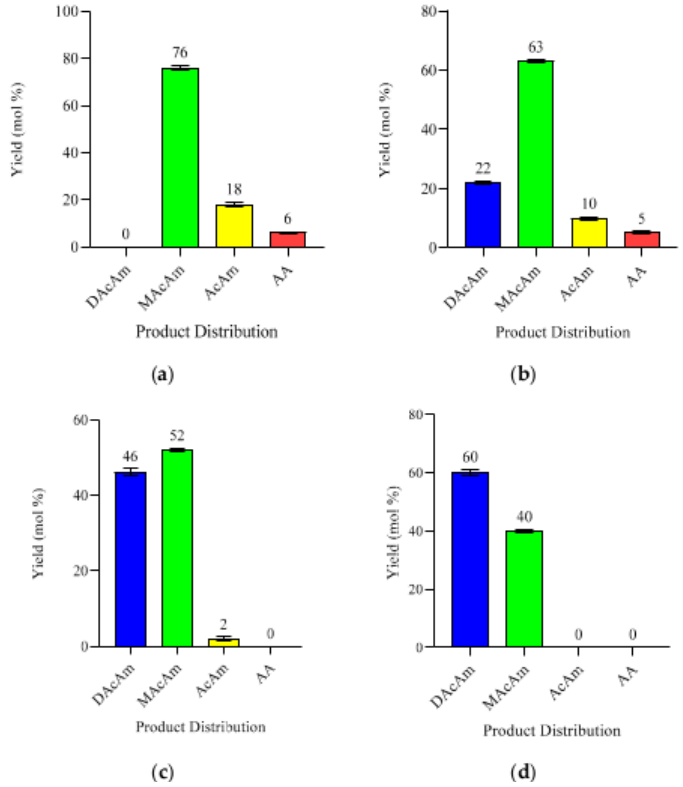
Figure 8. Products distributions of dehalogenation of dichloroacetamide performed in di ff erent reaction